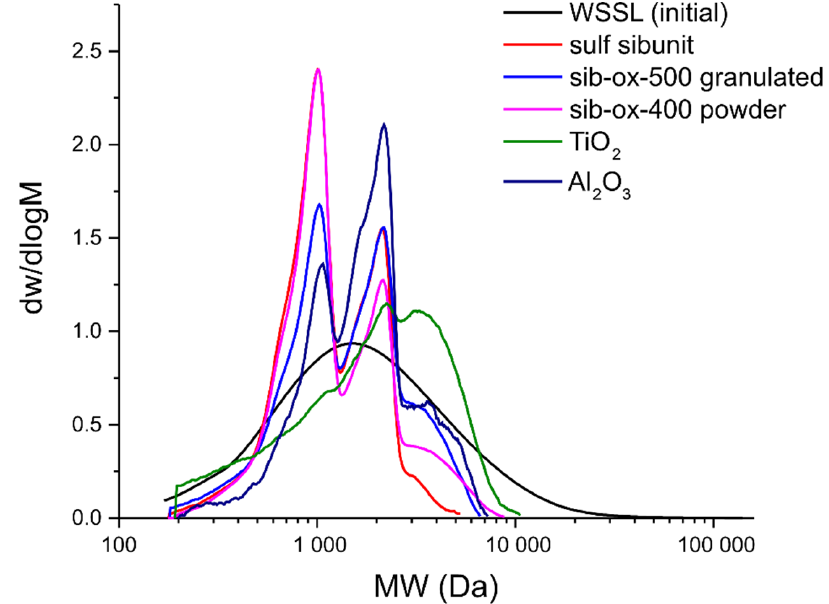
Figure 3. Molecular weight distribution for the WSSL samples.